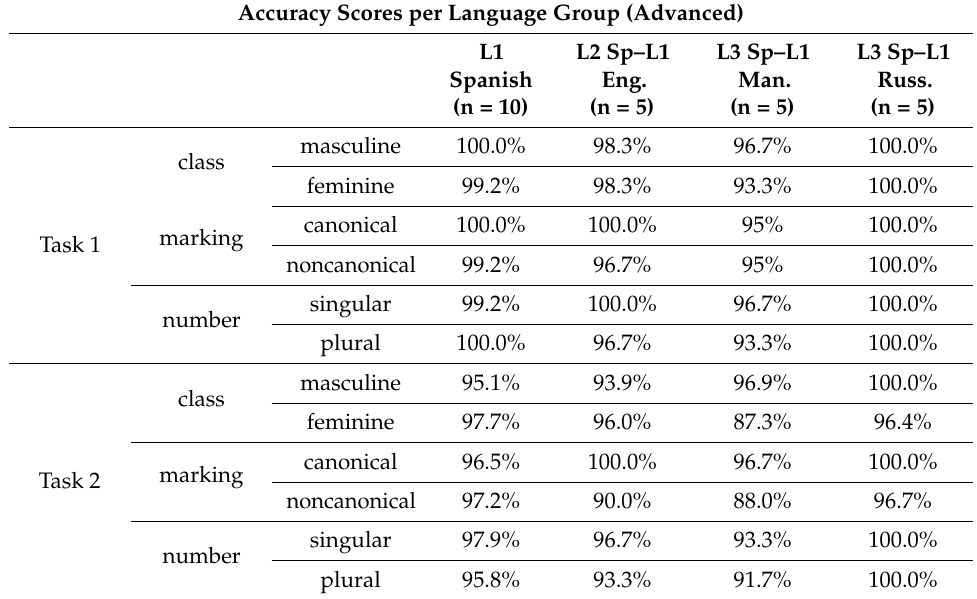
Table 2. Accuracy scores among the three advanced language groups in Task 1 and Task 2.